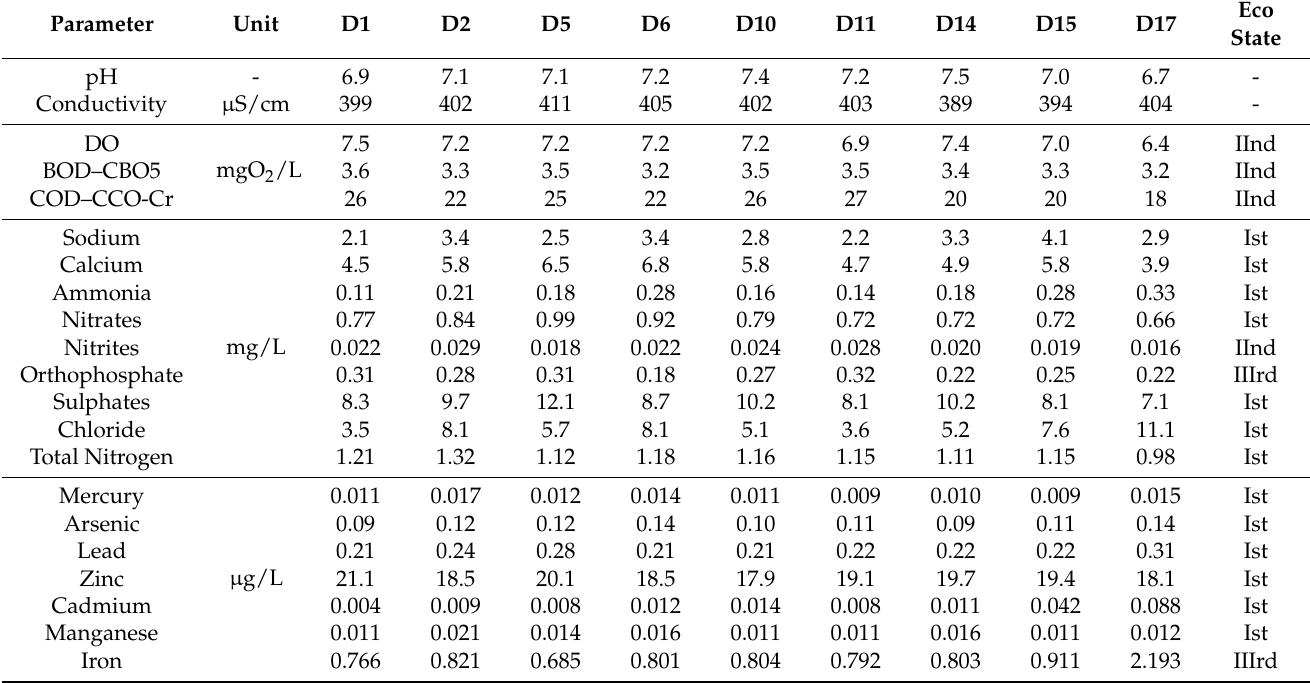
Table 2. Results obtained for parameter analysis in samples of Danube, July–September